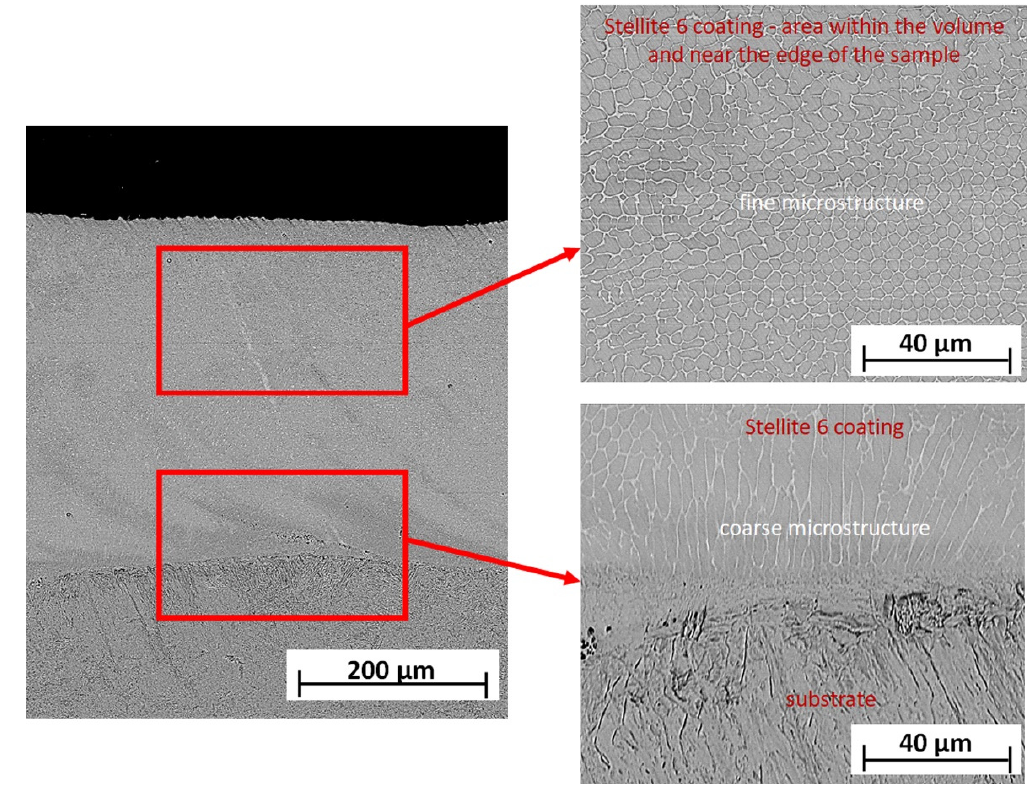
Figure 3. The SEM–BSE images of microstructure of Co-6 coating #4 (according to Table 1).